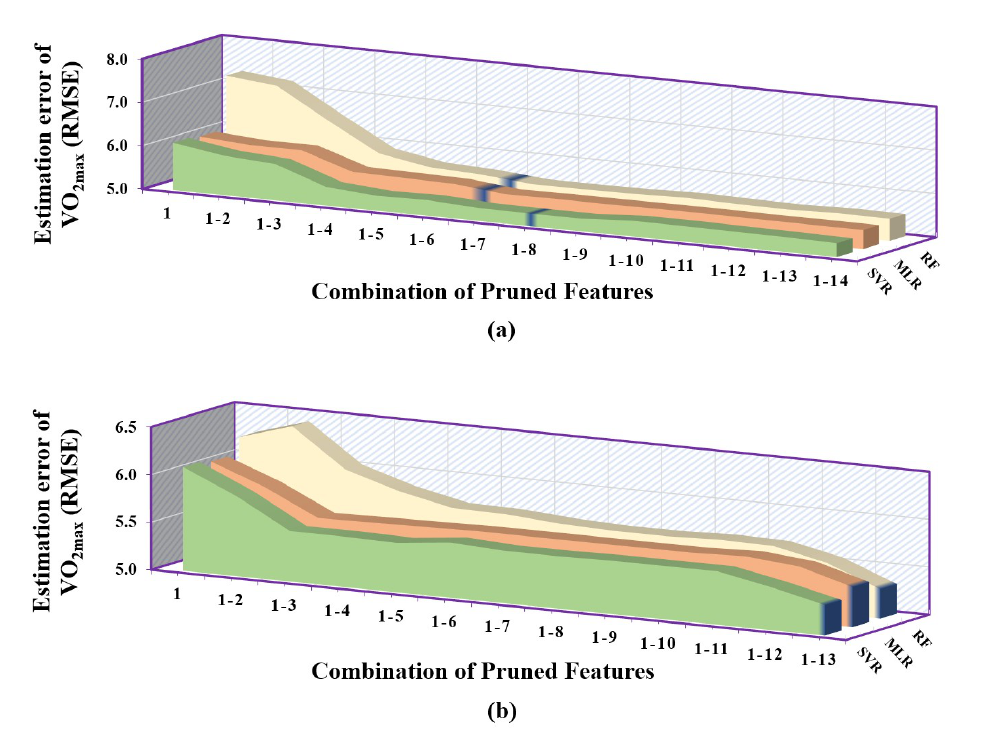
Figure 7. Error plot depicting the performance of regression models (MLR, RF, SVR) trained using a combination of pruned features associated with recovery data. The y–axis of each subplot shows prediction error using: ( a ) correlation–based feature selection method. ( b ) mutual information–based feature selection method. Each entry in the x–axis is represented in the form [1–N], which corresponds to the combination of 1st to N th feature set that is provided to regression